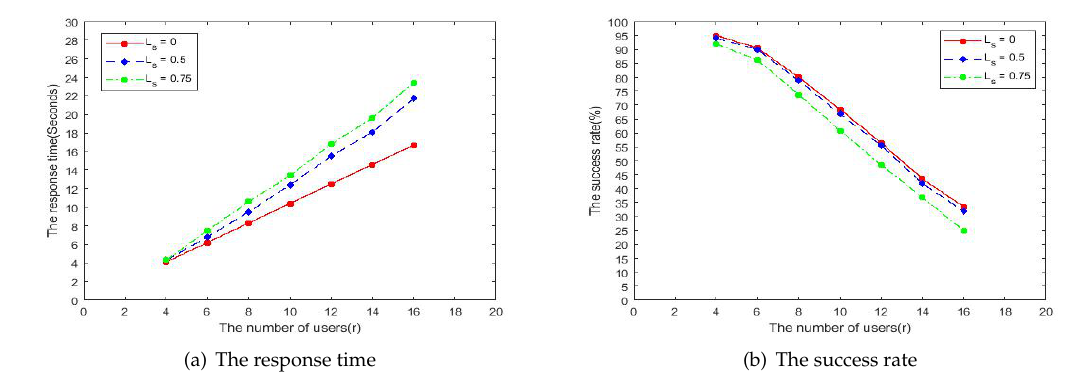
Figure 14. The simulation results of SCTB algorithm under different scenarios.